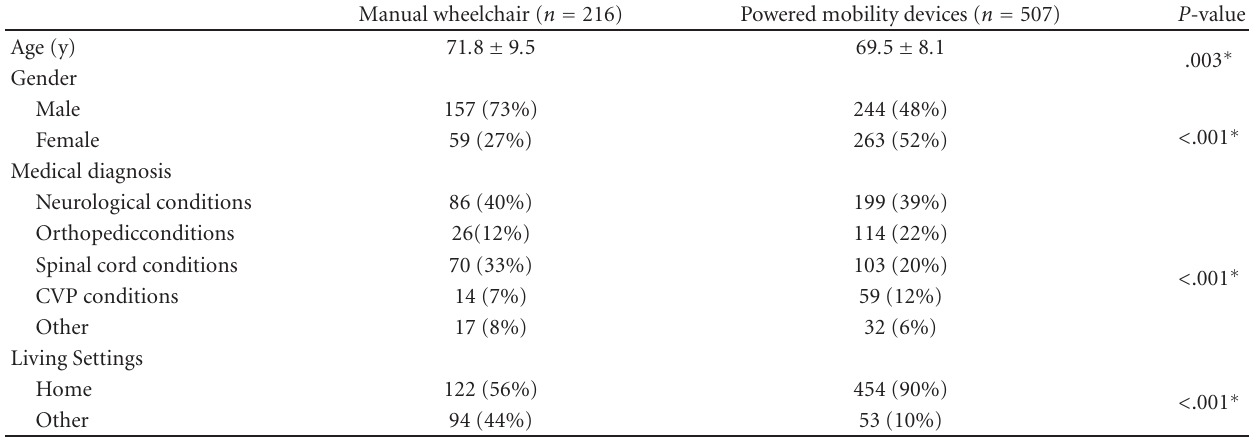
Table 2: Tier 1: Factors associated with use of manual versus powered mobility devices.